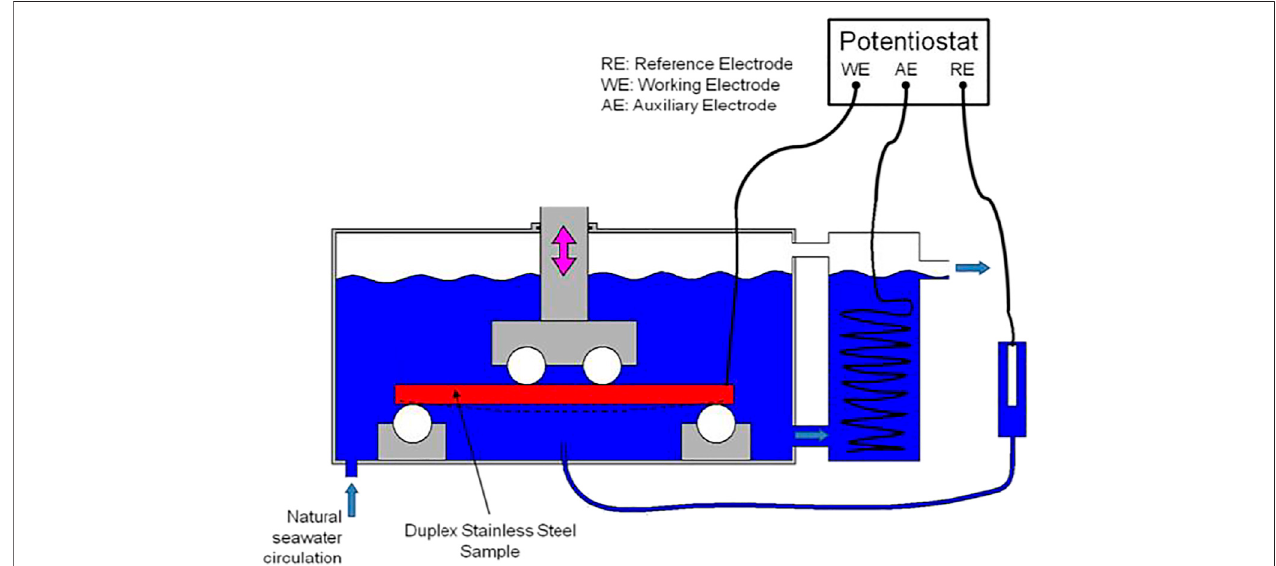
FIGURE 3 | Equipment to perform the 4-point bending fatigue test in natural seawater with CP.